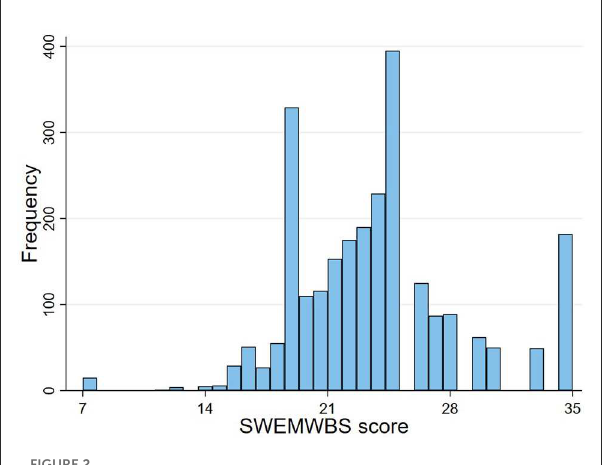
FIGURE2 Histogram of SWEMWBS variable.